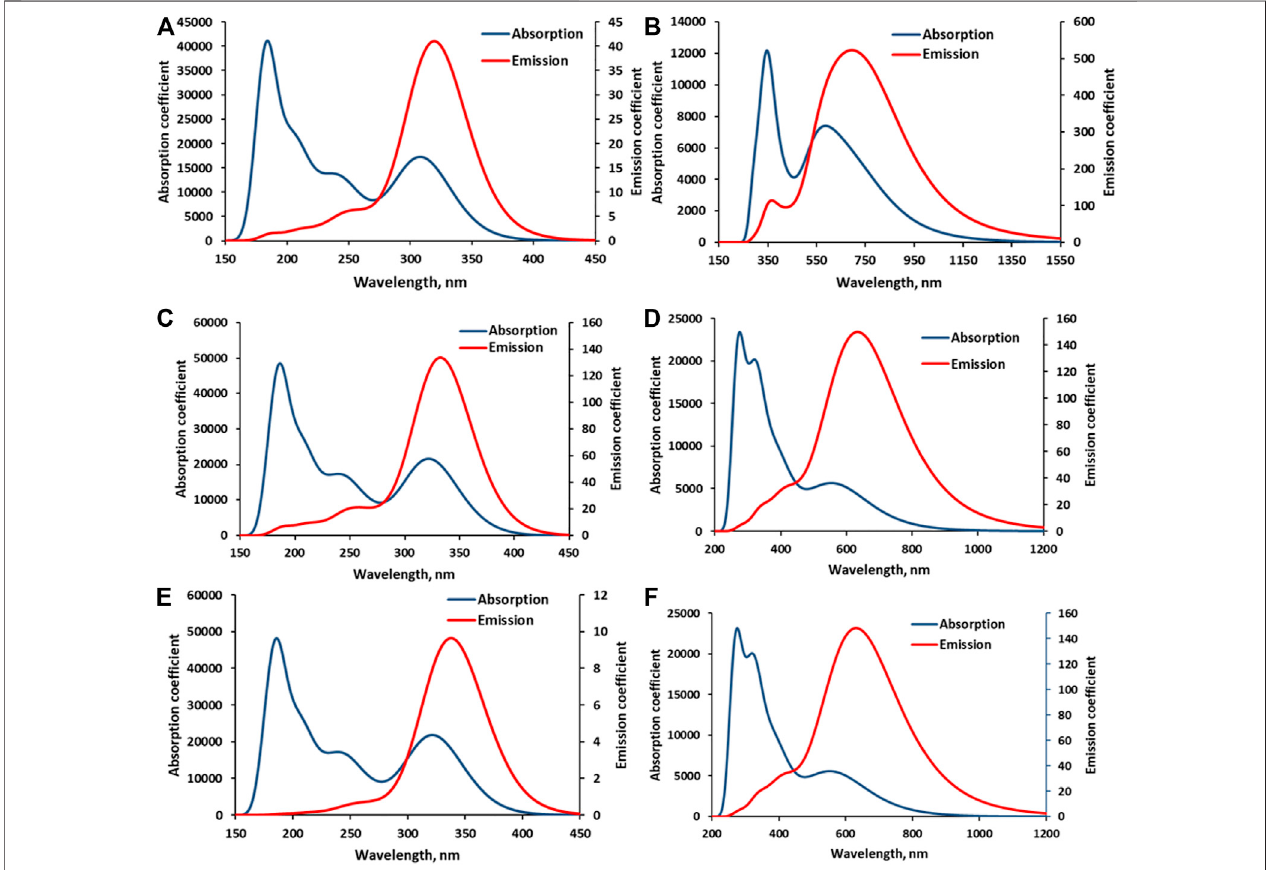
FIGURE 5 | Calculated electronic absorption and emission spectra of APG and BD in various media. (A) (cid:1) APG in the gas phase, (B) (cid:1) BD in the gas phase, (C) (cid:1) APG in EtOH, (D) (cid:1) BD in EtOH, (E) (cid:1) APG in AcCN, and (F) (cid:1) BD in AcCN.